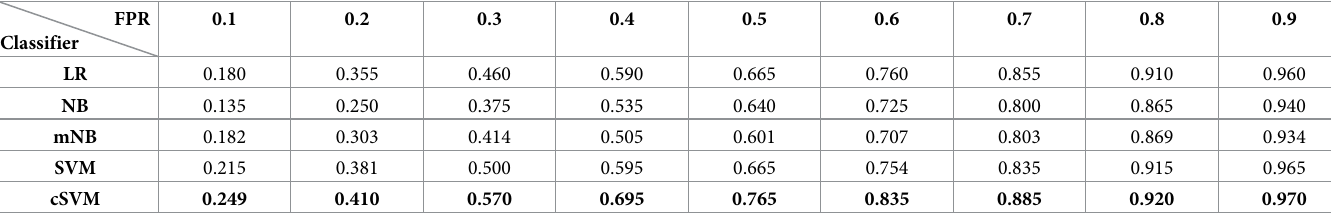
Table 2. TPR with respect to different